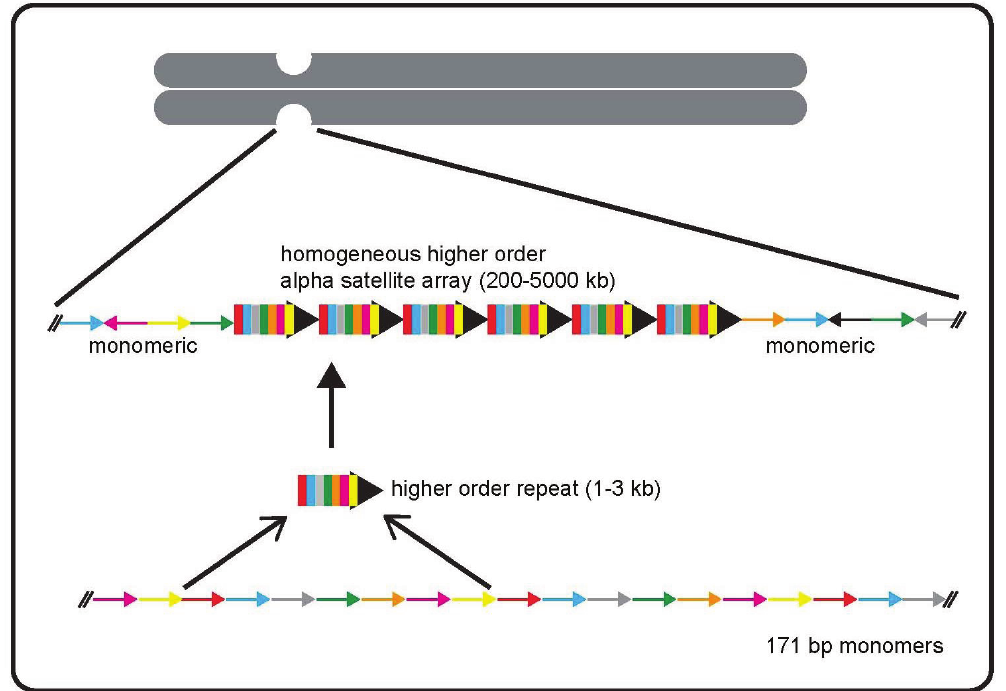
Figure 1. The genomic organization of human centromeres. The primary sequence at human centromeres is alpha satellite DNA that is based on 171 bp monomers (colored arrows) organized in a tandem head-to tail fashion. The monomeric sequences differ by as much as 40%. A set number of monomers give rise to a higher order repeat (colored bars with black arrowhead) and confer chromosome-specificity. Higher order repeats are themselves reiterated hundreds to thousands of times, so that the alpha satellite arrays are highly homogenous and span several hundred kilobases to several megabases. Unordered monomeric alpha satellite DNA flanks the higher order arrays, becoming progressively more divergent farther away from centromeric